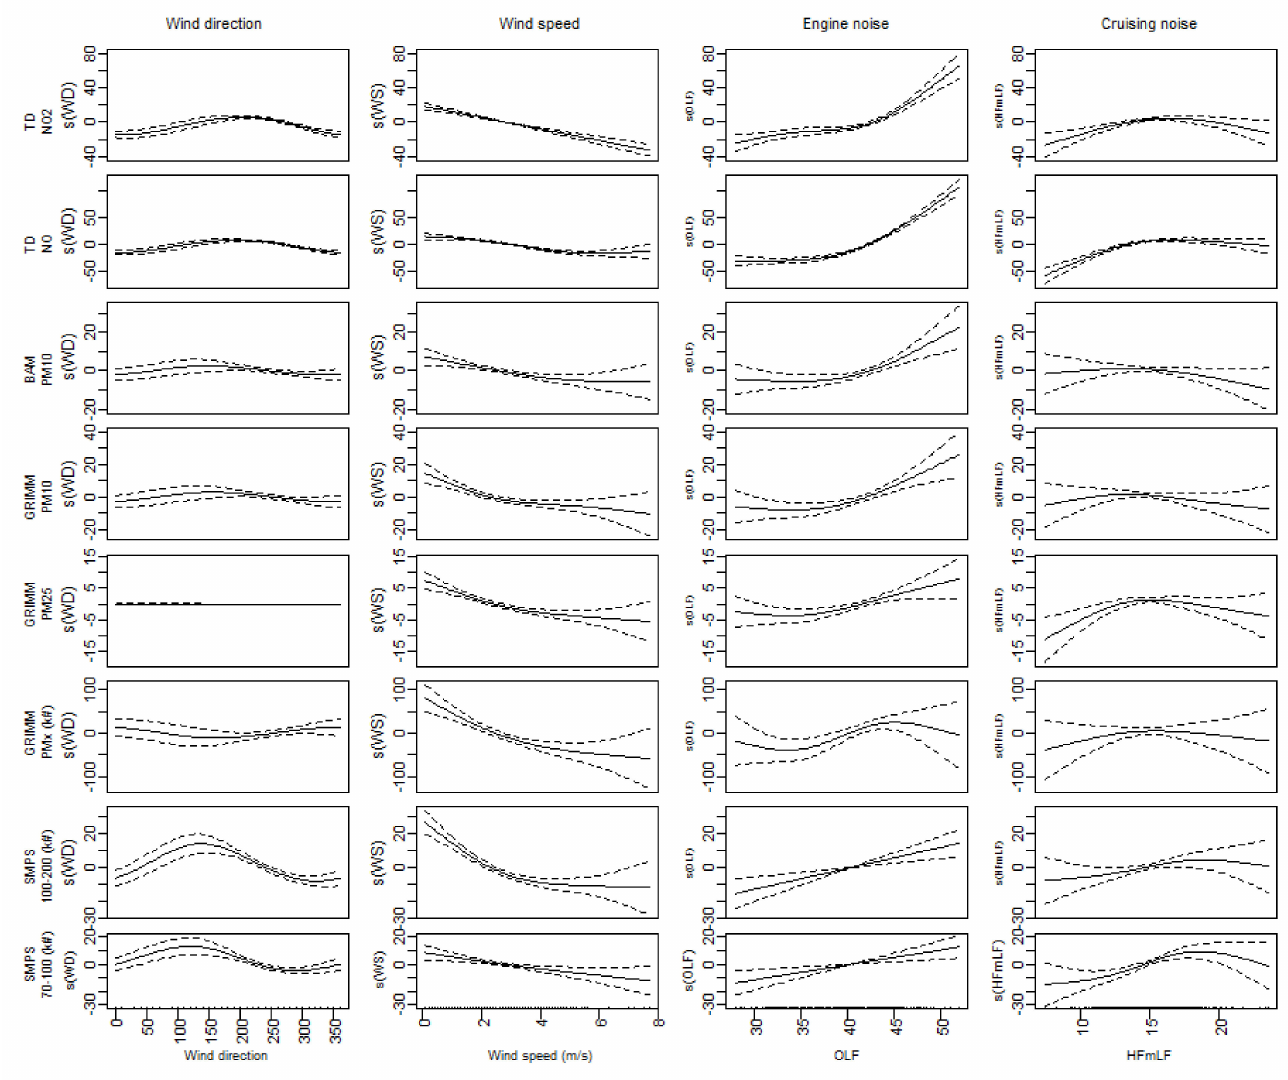
Figure 8. Selection of the basic noise-air pollution GAM models: NO 2 , NO, PM10 (BAM); PM10, PM2.5 and PMx (GRIMM); UFP count 100–200 nm and 70–100 nm